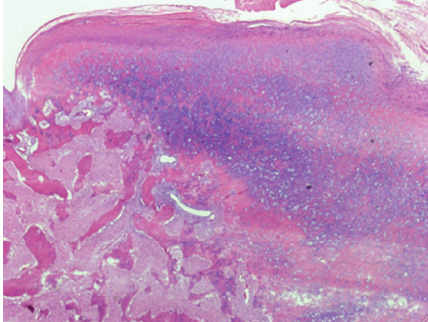
Figure 10: Low-power view of the lesion, demonstrating a cartilagi- nous cap and bony spicules (hematoxylin-eosin stain; magnification ×